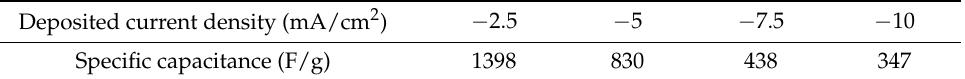
Table 1. The specific capacitance value of the sample by CV with a scan rate of 10 mV/s and 10 min deposition time.